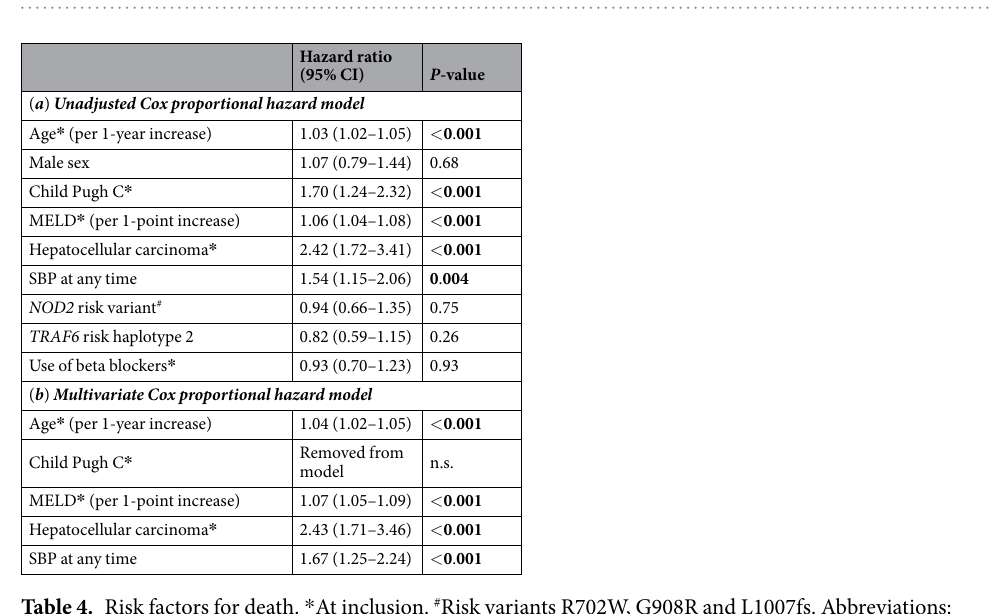
Table 4. Risk factors for death. * At inclusion. # Risk variants R702W, G908R and L1007fs. Abbreviations: confidence interval (CI), spontaneous bacterial peritonitis (SBP), tumor necrosis factor receptor-associated factor 6 (TRAF6), model for end-stage liver disease (MELD), nucleotide-binding oligomerization domain containing 2 (NOD2), not significant